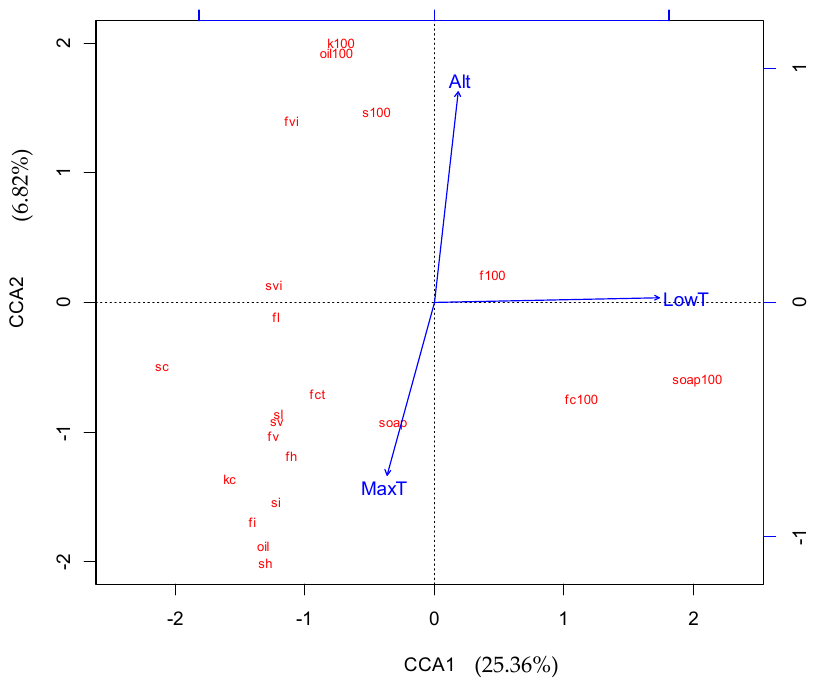
Figure 3. Simplified CCA ordination diagram of Sapindus mukorossi seed and fruit traits, and environmental factors.